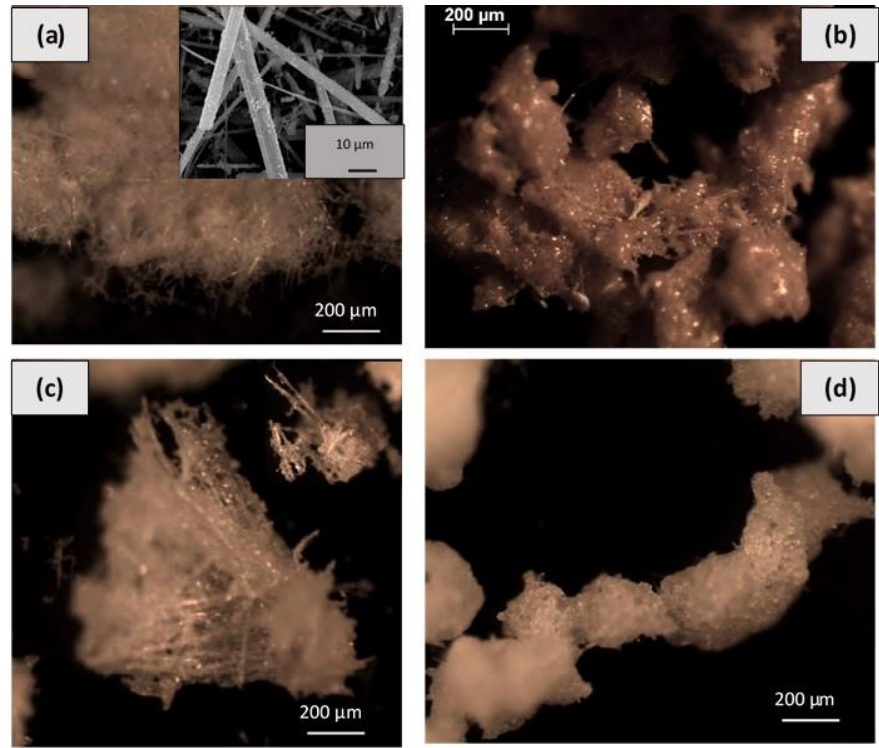
Figure 3. Optical microscope photos of natural ulexite: ( a ) uncalcined, ( b ) calcined at 600 °C, ( c ) calcined at 650 °C, and ( d ) calcined at 700 °C. Inset: SEM image of natural ulexite fibers.